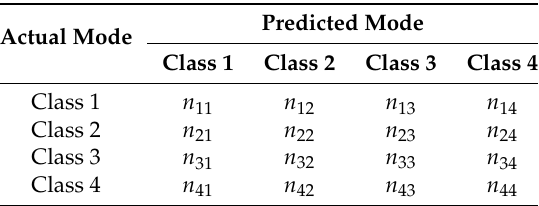
Table 2. Template of a confusion matrix for a four-class classifier.